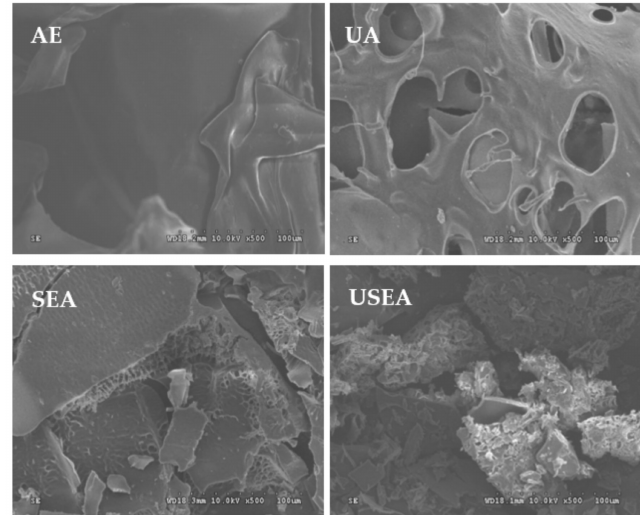
Figure 1. Morphology of pectin ( ×